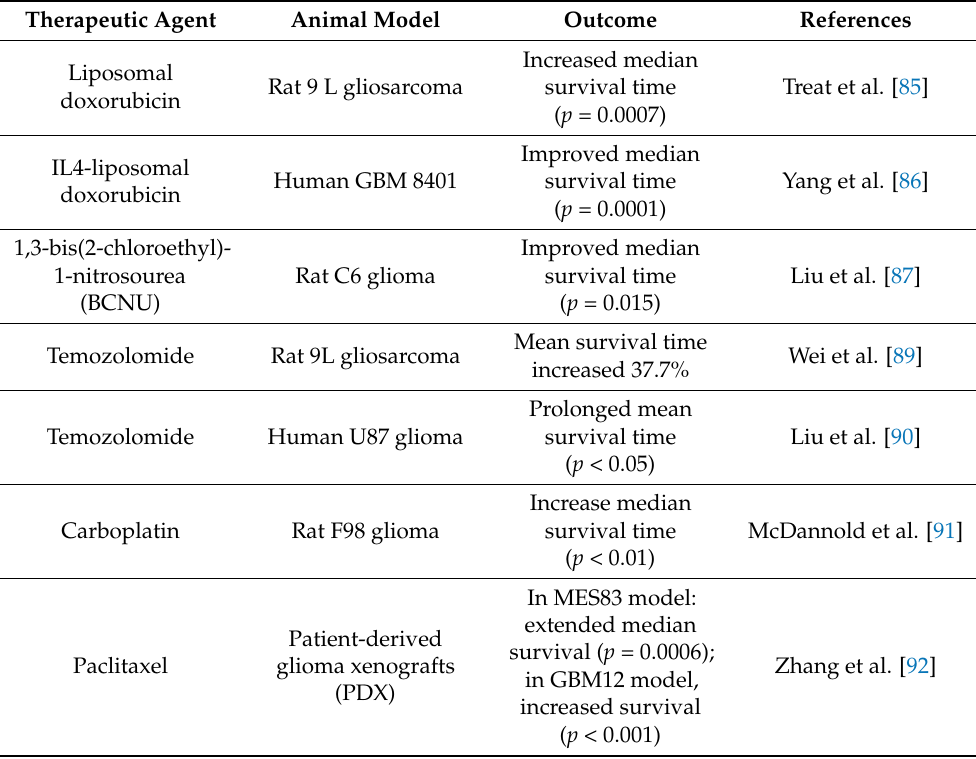
Table 2. Representative animal studies using FUS and therapeutics across the